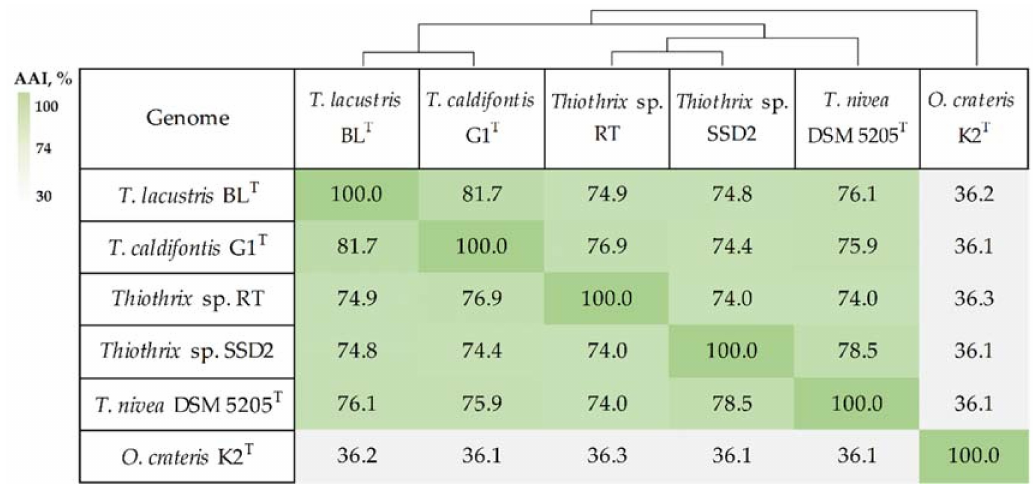
Figure 3. Heatmap of pairwise amino acid identity (AAI) values in the genus Thiothrix using Oceanispirochaeta crateris K2 T as an